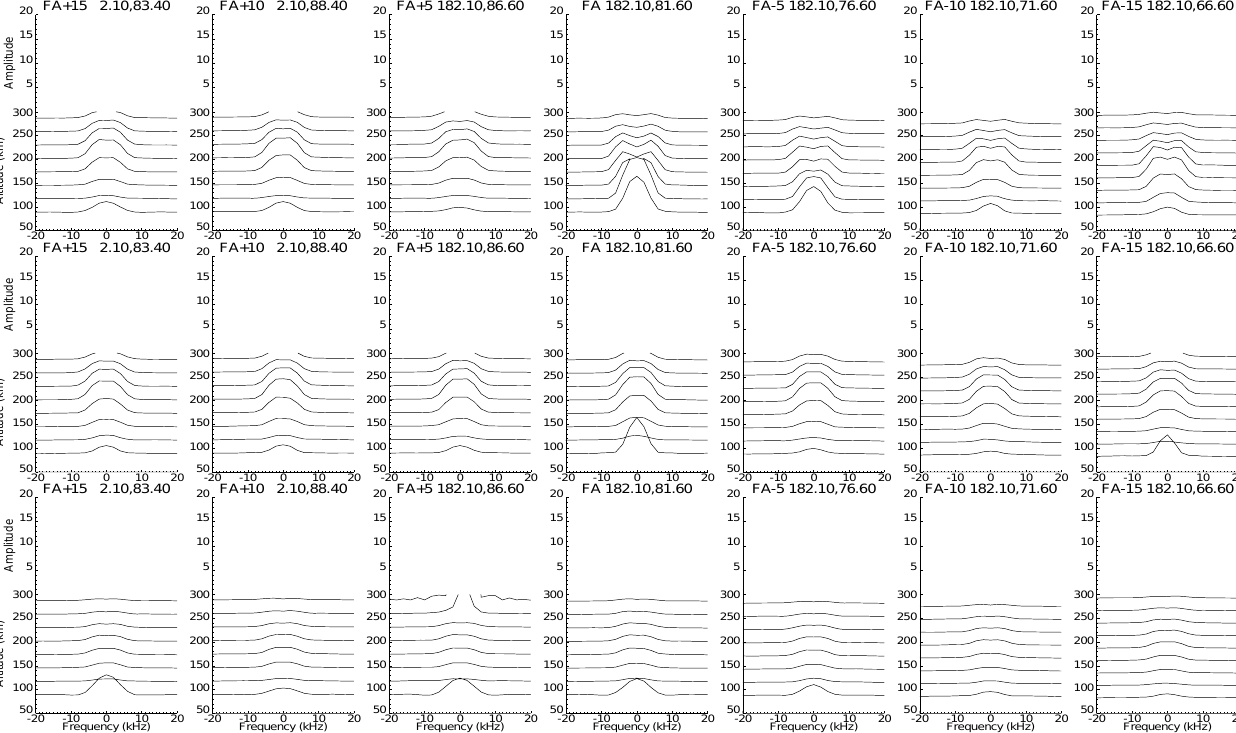
Fig. 7. Ion line spectra for scanning cycles 2, 4 and 6 from interval 1. For these data, and those from interval 2 shown in Figs. 8 and 9, each of the seven panels in each row shows temporally averaged ion line spectra from all times during which the ESR pointed in a specific direction, which ranged from FA+15 to FA − 15. Each panel direction is labelled using its designation, e.g. FA+10, followed by the azimuth and elevation of that pointing direction. The horizontal axis in each data panel shows the frequency and the other two axes show the altitude and the spectral amplitude. It is clear that significant E-region enhancements occur in FA+15, FA+5, FA and FA − 5, with notable increases in FA. Also, the central parts of the F-region spectra in FA+15, FA+10 and FA+5 are clearly